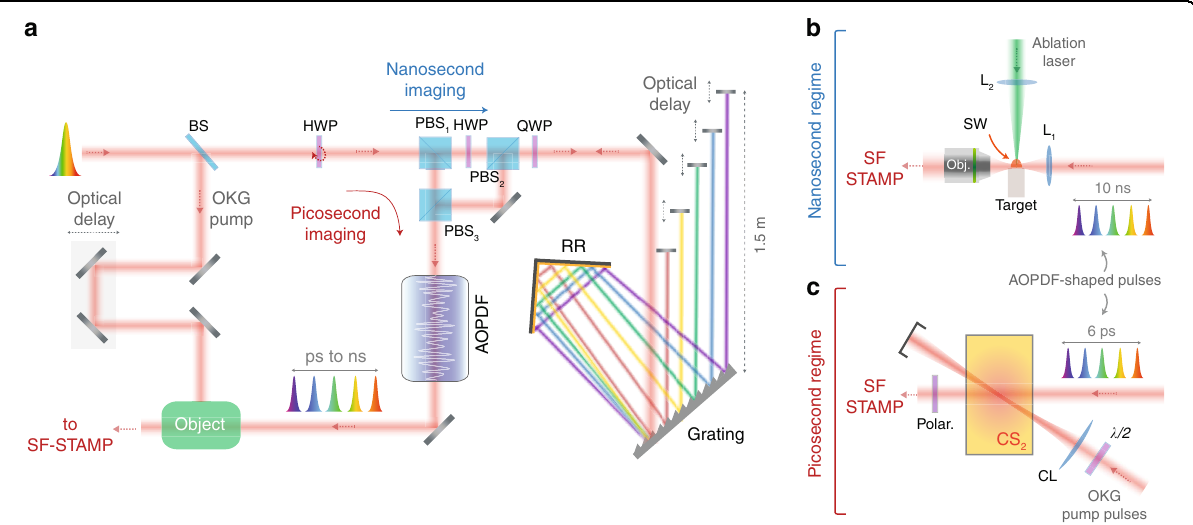
Fig. 3 AOPDF-based ultrafast imaging system. a Experimental setup. A half-wave plate allows to either operate the system in the picosecond or nanosecond regime. The latter is obtained using a grating-based stretcher with an additional adjustable delay between the sub-pulses prior to the AOPDF spectro-temporal shaping. b Experimental con fi guration used to generate and capture laser-induced shock waves (SW) on the nanosecond regime. SW are generated by focusing intense visible pulses onto solid targets. c Experimental con fi guration used for the picosecond-scale imaging of an optical Kerr gate (OKG) in a CS 2 cell. An optical delay line is used to synchronize the pump pulses with the imaging pulses in the CS 2 cell and to precisely capture the Kerr gate